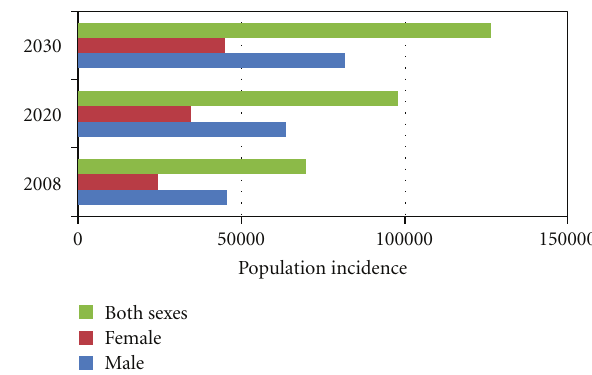
Table 5: Age standardized incidence rate—1993 to 1997.